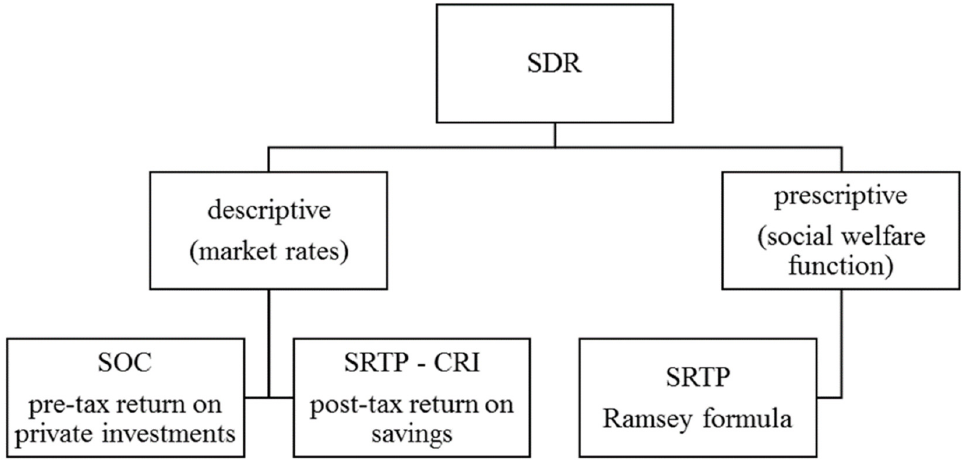
Figure 3. Main approaches to estimate the Social Discount